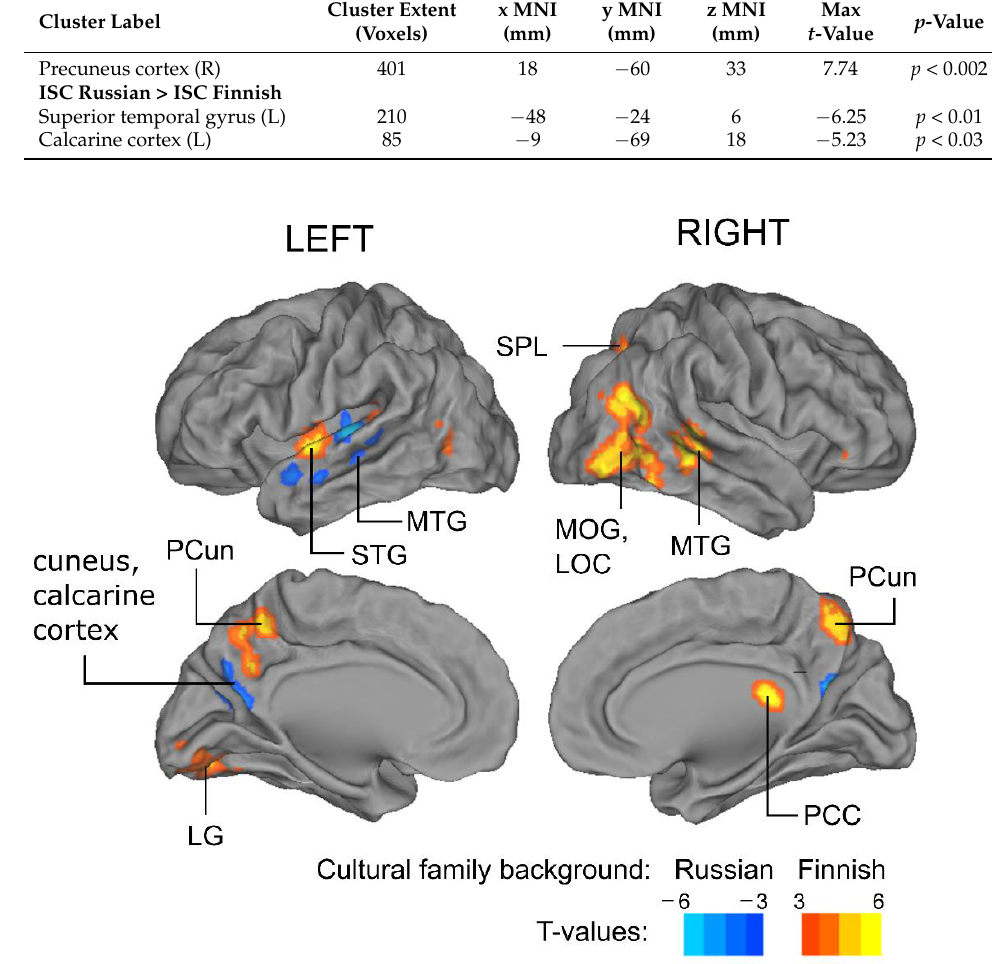
Figure 2. Brain areas where the activity was shaped by cultural family background. The brain areas where ISC was significantly different between the participants with the Finnish vs. Russian family backgrounds ( p < 0.05, adjusted with cluster-based thresholding using 5000 permutations and cluster-defining threshold of p < 0.001, uncorrected). Red–yellow means stronger ISC for the Finnish background and blue–light blue stronger ISC for the Russian background participants. Abbreviations: STG = superior temporal gyrus, MTG = middle temporal gyrus, LOC = lateral occipital cortex, MOG = middle occipital gyrus, PCun = precuneus, SPL = superior parietal lobule, LG = lingual gyrus, PCC = posterior cingulate cortex. The loci of ISC were labeled according to the Harvard–Oxford Cortical Structural Atlas [61] implemented in FSL. The results were visualized on the cortical surface using Caret software [62]. Please note that the ISC difference in PCC was misleadingly projected in the ventricle when visualized using Caret. Table 3. Differences of ISC values between Finnish- and Russian-family-background participants. Cluster size, peak coordinates, the maximum t -values and p-values of the clusters obtained in the nonparametric two-sample t -test between the two participant groups (5000 cluster-wise permuta- tions; cluster-defining threshold, uncorrected: p < 0.001; the 0.05 family-wise error-corrected cluster size: 62 voxels). The loci of ISC were labeled according to the Harvard–Oxford Cortical Structural Atlas [61] implemented in FSL.